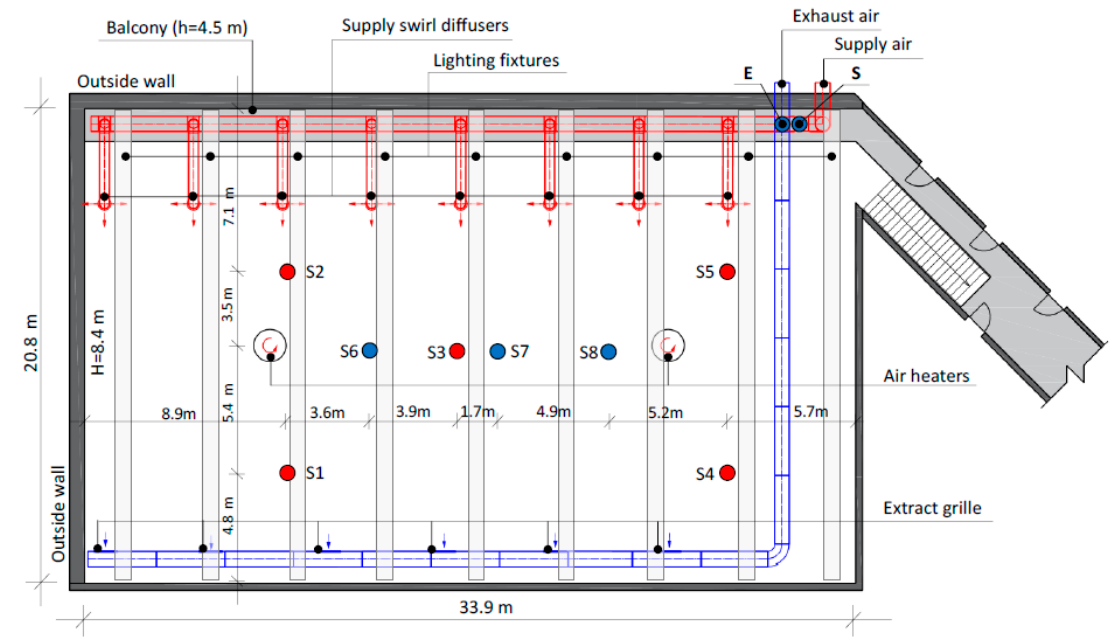
Figure 2. Heating and ventilation equipment, as well as measurement equipment locations in the training hall (S1–S8: locations of stands; E, S: locations of CO 2 m).